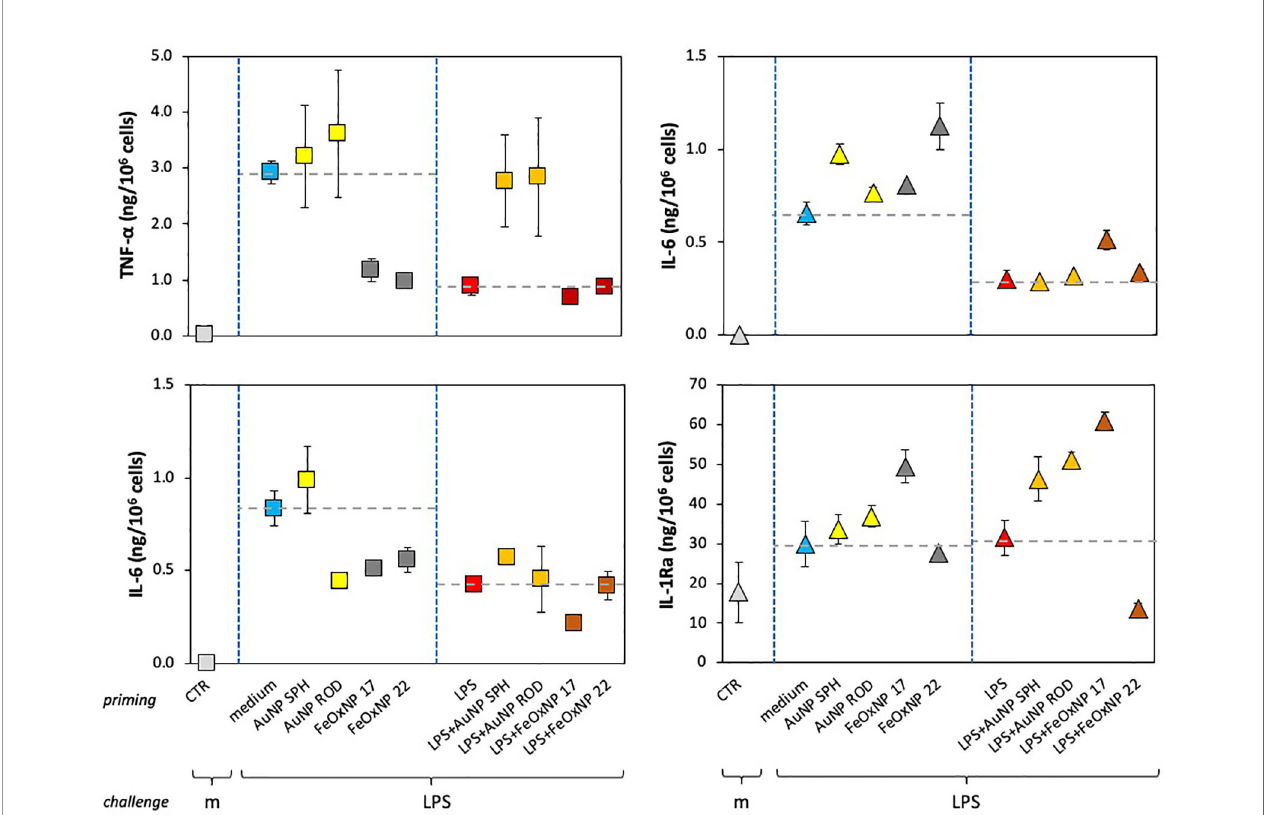
FIGURE 4 | Innate memory response of human monocytes from individual donors, primed with AuNP or FeOxNP alone or together with LPS. Human monocytes isolated from blood of two individual donors (donor 3, square symbols, left panels; donor 2, triangle symbols, right panels) were cultured for 24 h in culture medium alone or containing serum-precoated NP: 5.7 µg/ml AuNP SPH, 1.4 µg/ml AuNP ROD, 2 µg/ml FeOxNP 17 and 2.7 µg/ml FeOxNP 22, alone or together with 1 ng/ml LPS (line priming in abscissa). Cells were then washed and rested for 6 days in the absence of stimuli, then challenged for 24 h in fresh medium alone or containing 5 ng/mL LPS (m and LPS in the abscissa line challenge ). The production of TNF a (upper left), IL-6 (upper right and lower left), and IL-1Ra (lower right) was measured in the 24 h supernatants by ELISA. Data are reported as mean ± SD of replicate determination from individual donors out of four tested (all shown in Figure 3 ). Horizontal dotted lines represent the reference values of cells primed with medium alone and cells primed with LPS in the two parts of each panel. The basal response of control cells (CTR), i.e. , primed or unprimed cells rested for 6 days and then exposed for 24 h to medium alone, is shown at the extreme left in each panel (grey symbols). Statistical signi fi cance is as follows. Upper left panel: CTR vs . medium, p < 0.0001; medium vs. LPS, p < 0.005; medium vs . FeOxNP, p < 0.005; LPS vs . LPS + AuNP, p < 0.05. Upper right: CTR vs . medium, p < 0.0001; medium vs. LPS, p < 0.005; medium vs . AuNP SPH and FeOxNP 22, p < 0.05; LPS vs. LPS + FeOxNP 17, p < 0.05. Lower left: CTR vs . medium, p < 0.0001; medium vs. LPS, p < 0.01; medium vs . AuNP ROD, FeOxNP 17 and FeOxNP 22, p < 0.05; LPS vs . LPS + FeOxNP 17, p < 0.05. Lower right: medium vs . FeOxNP 17, p < 0.05; LPS vs . LPS + all NP, p < 0.05. All other relevant comparisons are not signi fi